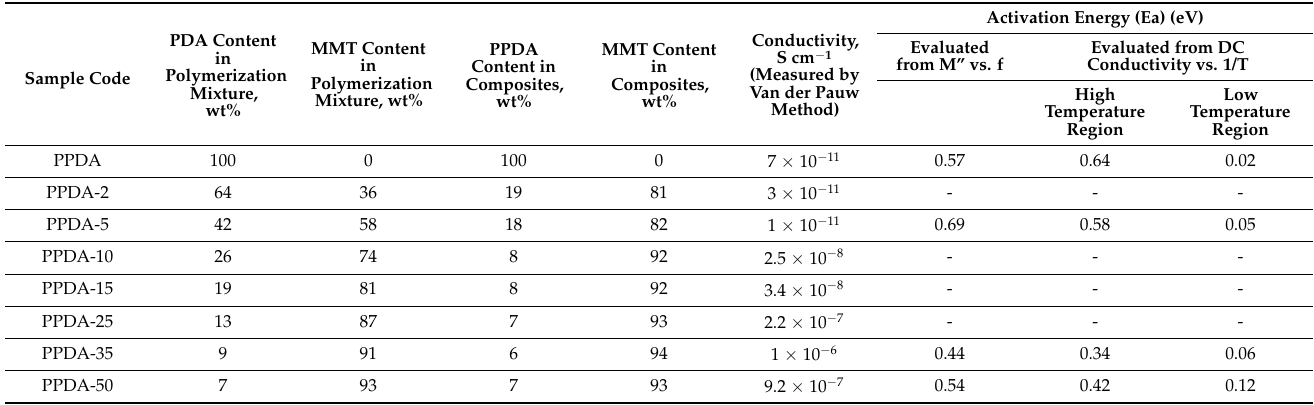
Table 1. The montmorillonite content and DC conductivity of PPDA/MMT